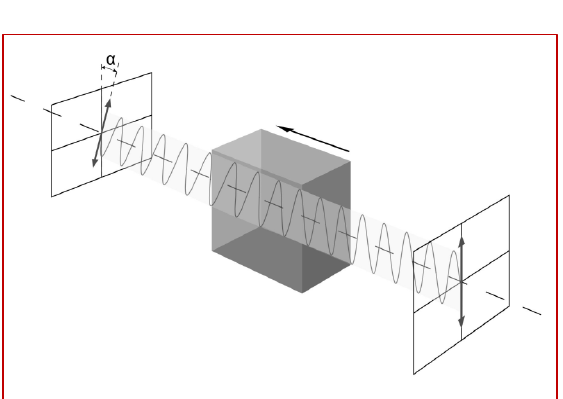
Figure 1. Classical presentation setup to show the effect of the light plane polarization rotation.